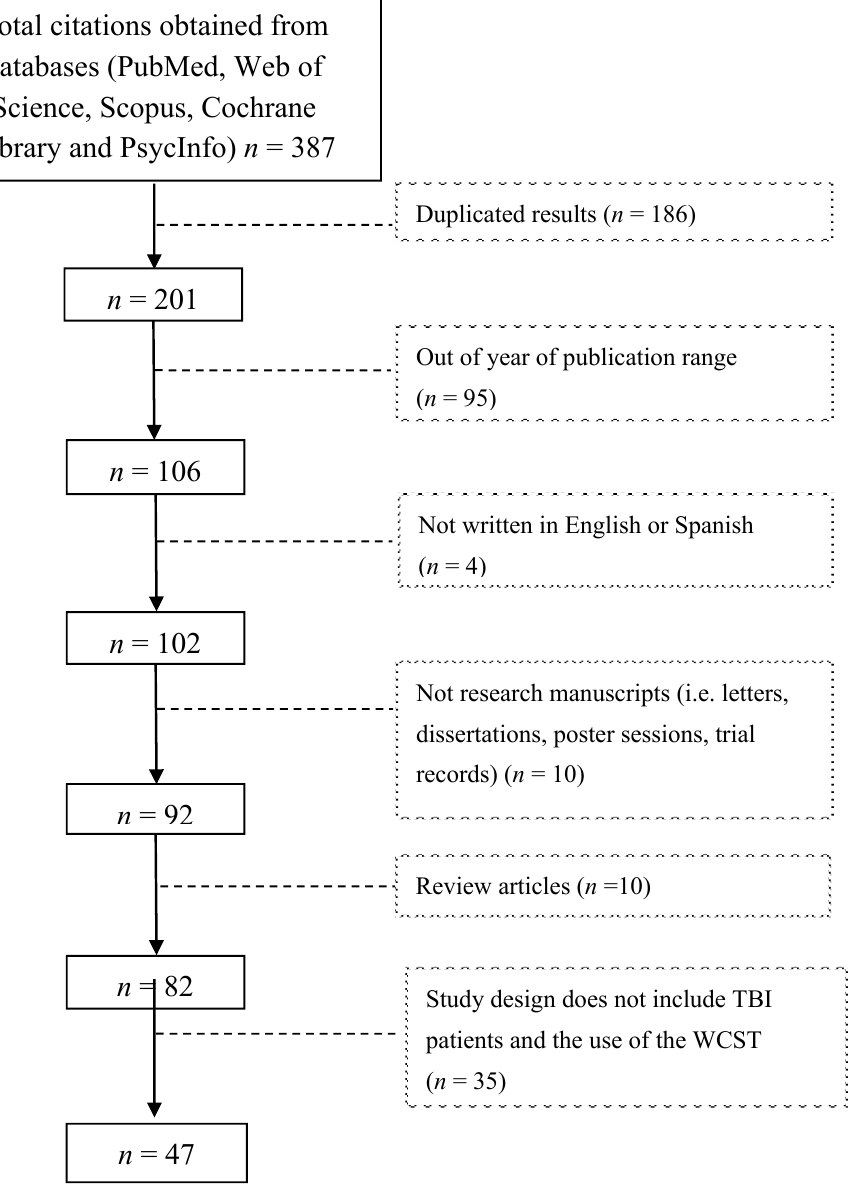
Figure 1. Study flow diagram.